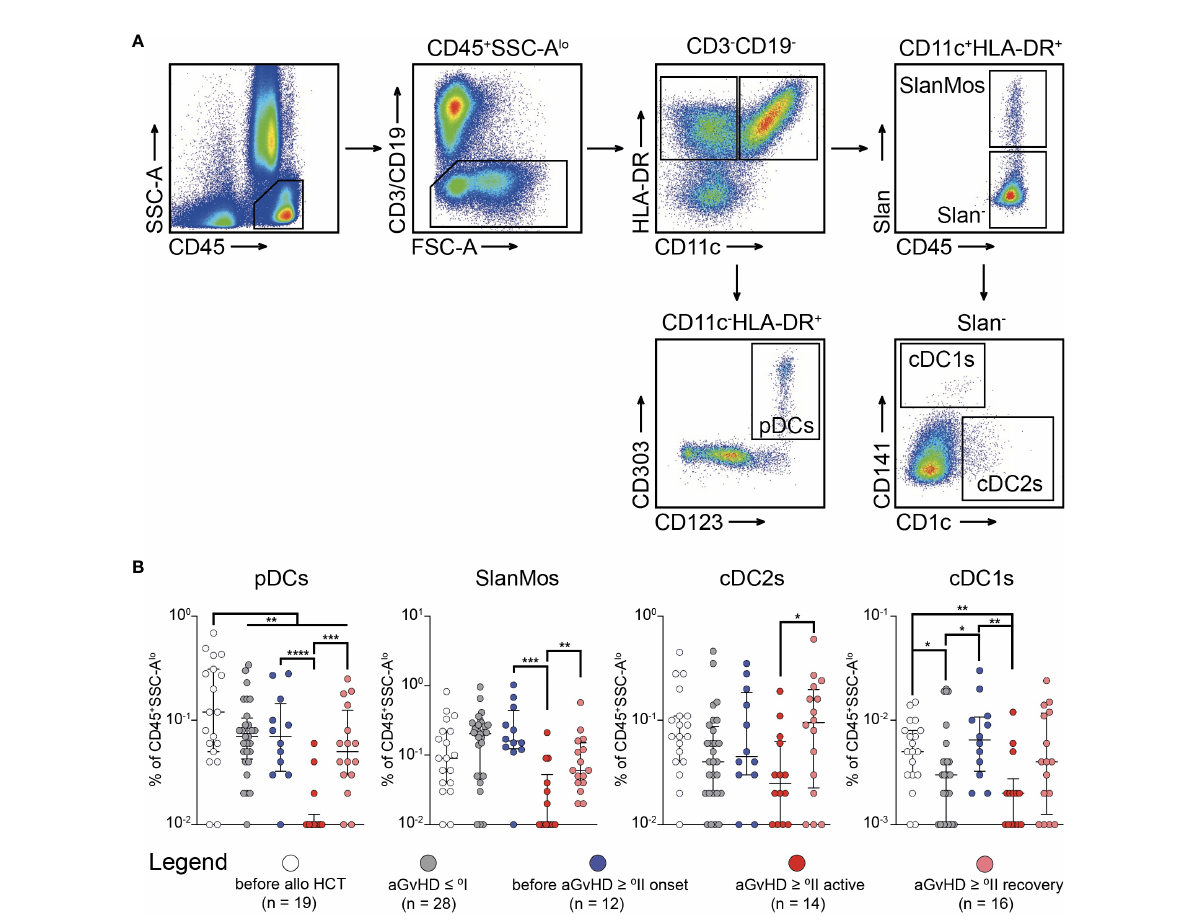
FIGURE 5 In fi ltration of CD141 + dendritic cells occurs prior to active acute graft-versus-host-disease ≥ °II and is depleted with immunosuppressive treatment. (A) The gating strategy to identify subpopulations of dendritic cells (DCs) in bone marrow (BM) aspirates is shown. CD45+SSCloCD3 − CD19 − HLA- DR+ cells were further characterized as plasmacytoid DCs (CD11c − CD123+CD303+) (pDCs), Slan-positive monocytes (CD11c+Slan+) (SlanMos), type 1 classical DCs (CD11c+Slan − CD141+CD1c − ) (cDC1s), and type 2 classical DCs (CD11c+Slan − CD141 − CD1c+) (cDC2s). (B) Frequency of DC subpopulations in percentage of CD45+ cells in BM aspirates. Graphs show individual values with median and interquartile ranges. The Mann- Whitney test was used for statistical analysis; *P < 0.05, **P < 0.01, ***P < 0.001, ****P <